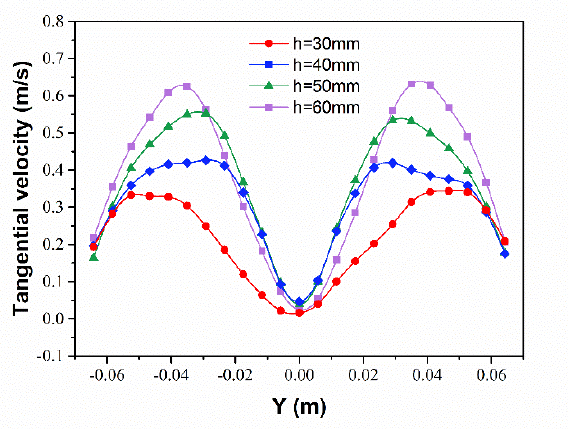
Figure 17. The tangential velocity at H = 0.015 m on YZ plane of the four stirred tanks with different blade heights.